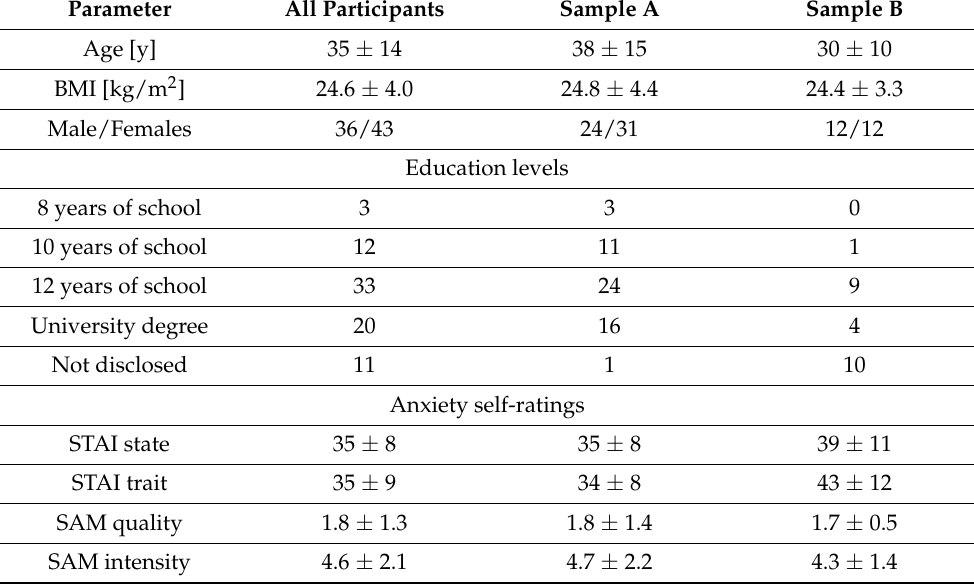
Table 1. Demographic data of the final sample including 79 healthy volunteers. Parameter All